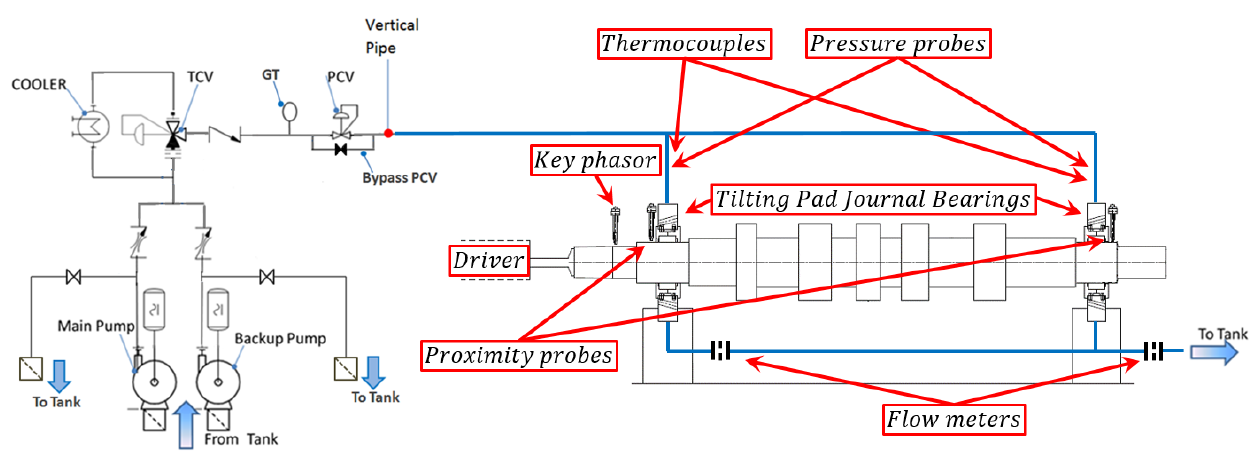
Figure 11. Simplified scheme of the experimental test rig in Figure 10. In addition to the thermocouples, there are also resistance thermometers on the pad placed at the bearings midspan: the resistance thermometers are able to measure the fluid film temperature inside the bearings. The lubricant used for the tests (Table 2) is referred